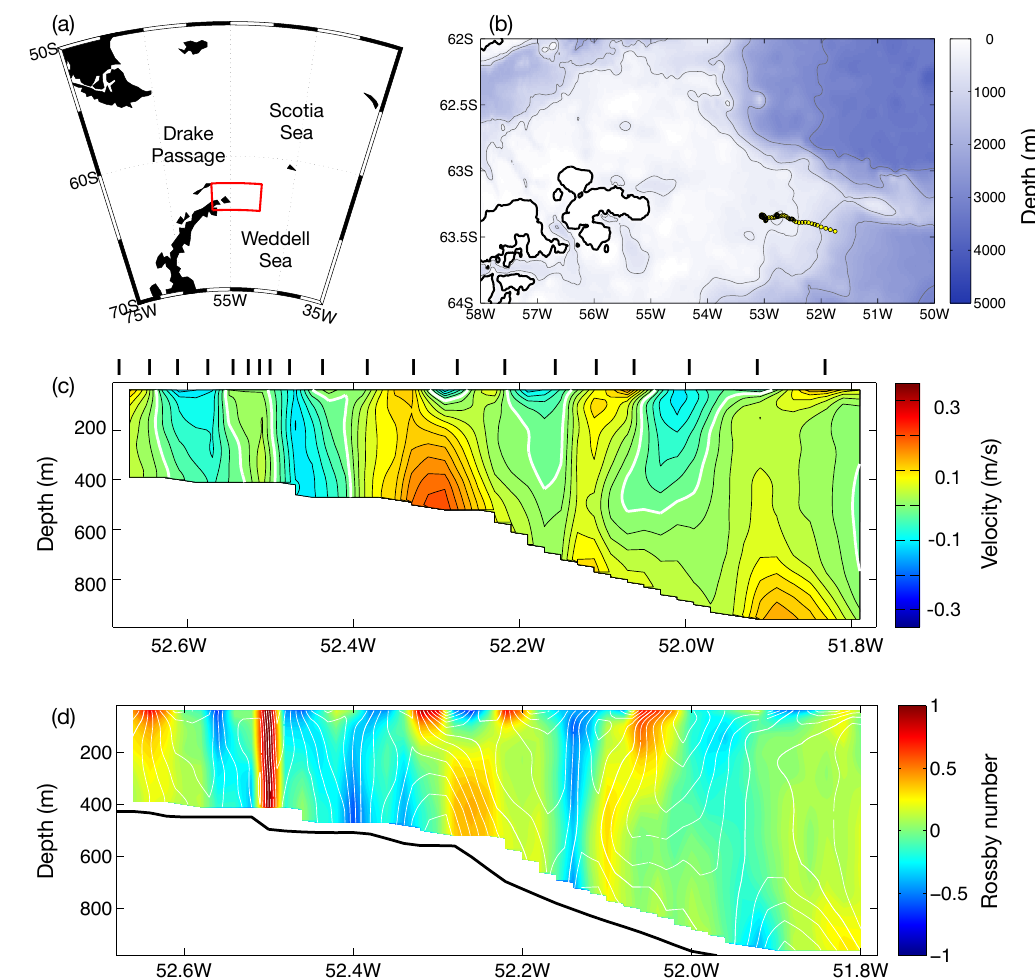
Figure 1. ( a ) Overview map of the Weddell Sea sector of the Southern Ocean. ( b ) An enhanced view of the red box in panel ( a ), where bathymetry (m) is given in color. Circles in panel ( b ) correspond to a single hydrographic transect collected by an ocean glider in January 2012. ( c ) Vertical, cross-slope section of cross-transect (along-slope) velocity, v ; the zero contour is given in white. ( d ) Rossby number approximated by v x / f , where x is the cross-slope direction of the same transect in panel ( c ). Tick marks at the top of panel ( c ) indicate the surfacing positions of each glider dive. See Thompson et al. [23] for further